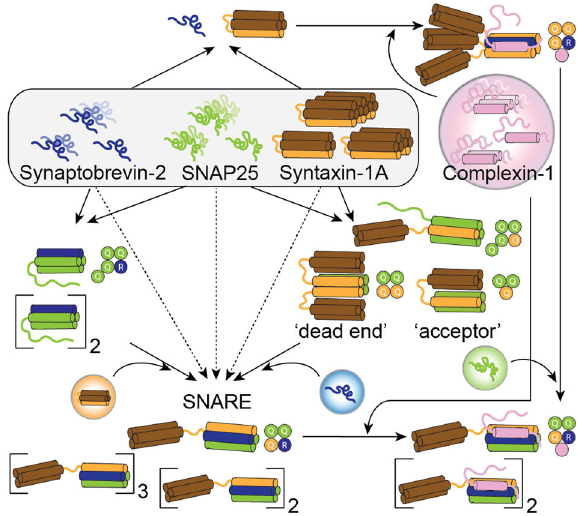
Fig. 7 Roadmap of SNARE complex assembly. Complexes observed by native MS when mixing Synaptobrevin-2 (blue), SNAP25 (green), Syntaxin- 1A (orange) and Complexin-1 (pink) are shown as cartoons. The stoichiometry of the complexes as observed in native mass spectra is indicated.